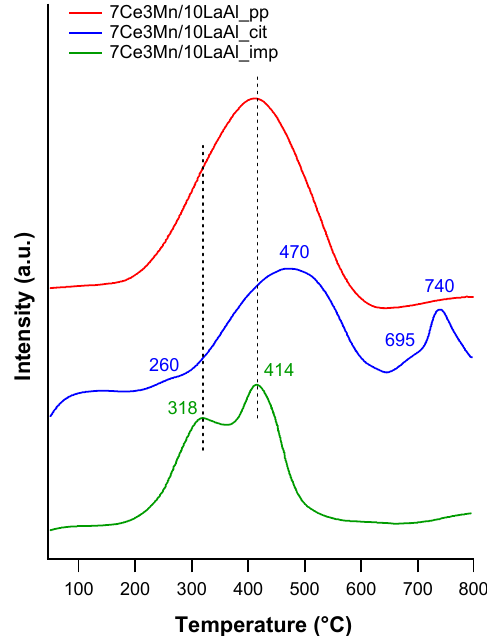
Figure 5. TPR–H 2 profiles of the studied CeMn/LaAl samples.